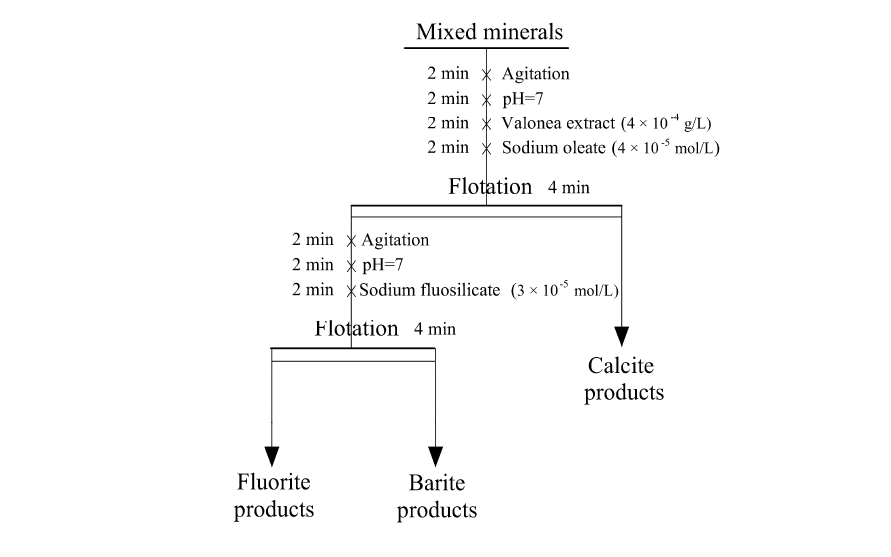
Figure 6. Flotation flowsheet of selective separation. Table 3. Experimental results of mixed minerals’ flotation.